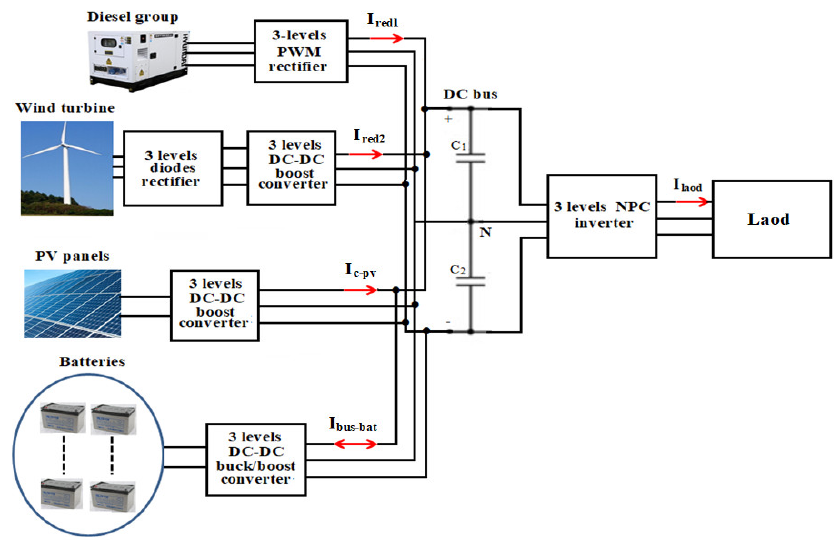
Figure 1. Hybrid system